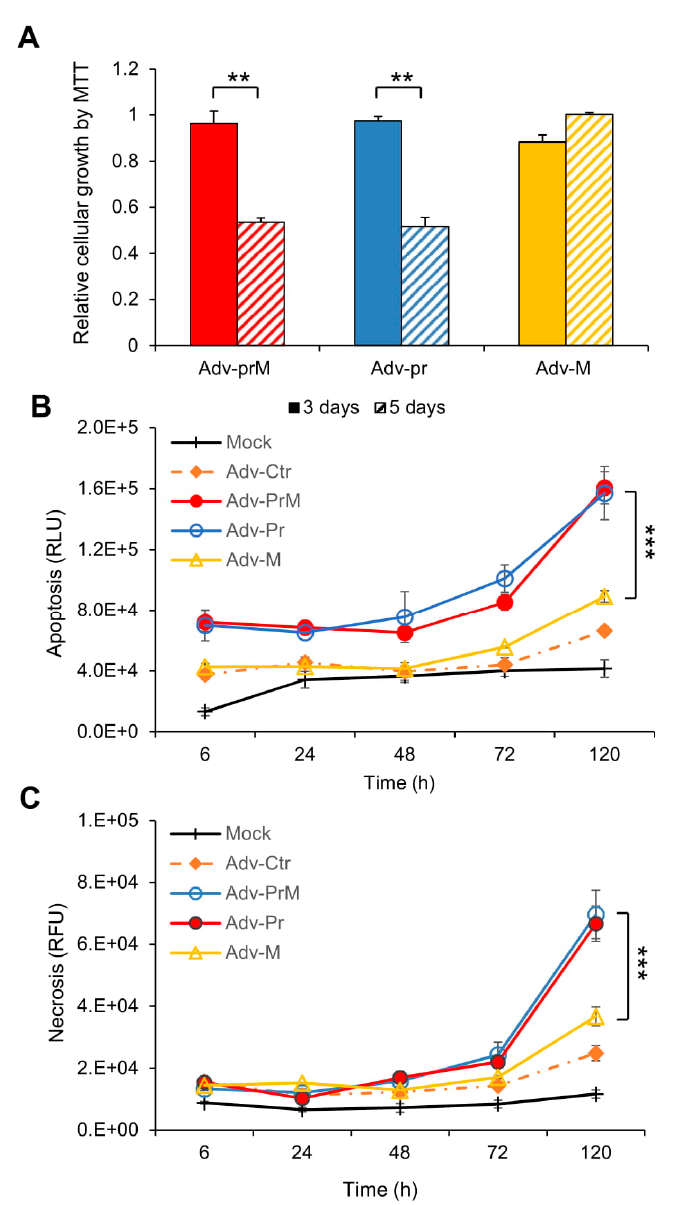
Figure 5. Effect of prM protein processing on ZIKV-induced neurocytotoxicity. ( A ) Cell proliferation and viability was measured overtime by the MTT assay. The graph is plotted as the relative growth in relevance to mock infected SNB-19 cells. The differences shown were highly significant with p < 0.05 (**). ( B ) Measurement of apoptosis by Annexin V over time. The difference between Adv-prM and Adv-M was highly significant with p < 0.01 (***), but the difference between Adv-prM and Adv-Pr was not significant with p = 0.84. ( C ) Measurement of cellular necrosis over time. Two-way ANOVA was used to calculate the difference between Adv-prM and Adv-M for ( B ) and ( C ). The differences between Adv-prM and Adv-M were highly significant with p < 0.01 (***). More than two different experiments were conducted to evaluate apoptosis and necrosis. All results represent average and standard deviation (X+SD).